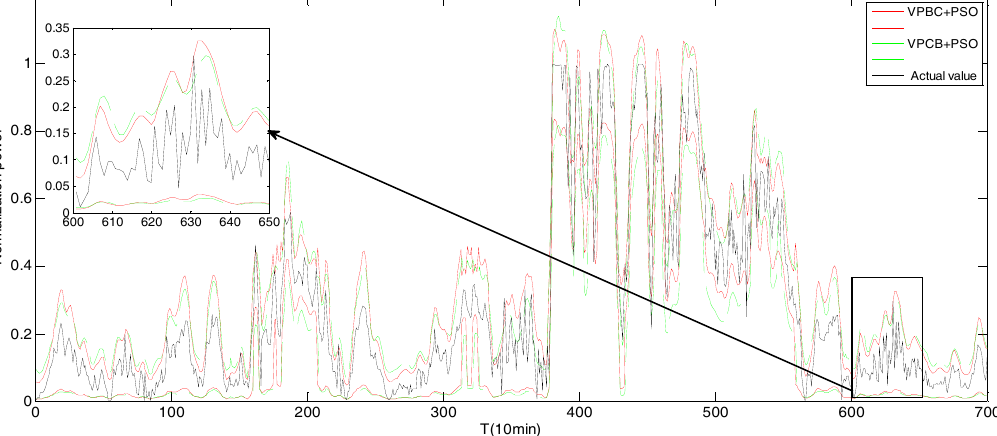
Figure 12. Forecasting results of the VPBC + PSO and VPCB + PSO methods at 90% PINC.